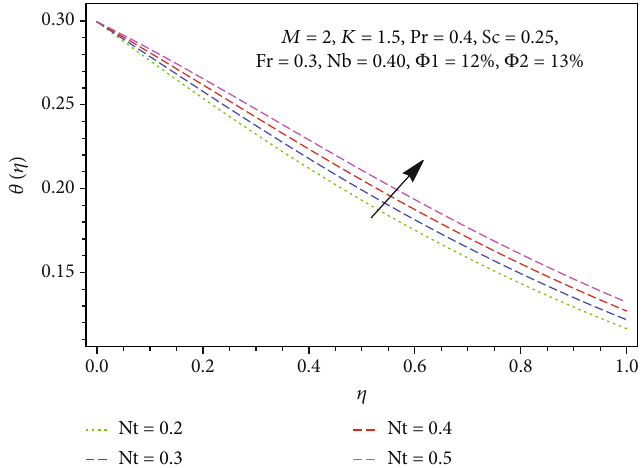
Figure 17: Impact of thermophoresis parameter Nt over energy pro fi le θ ð η Þ